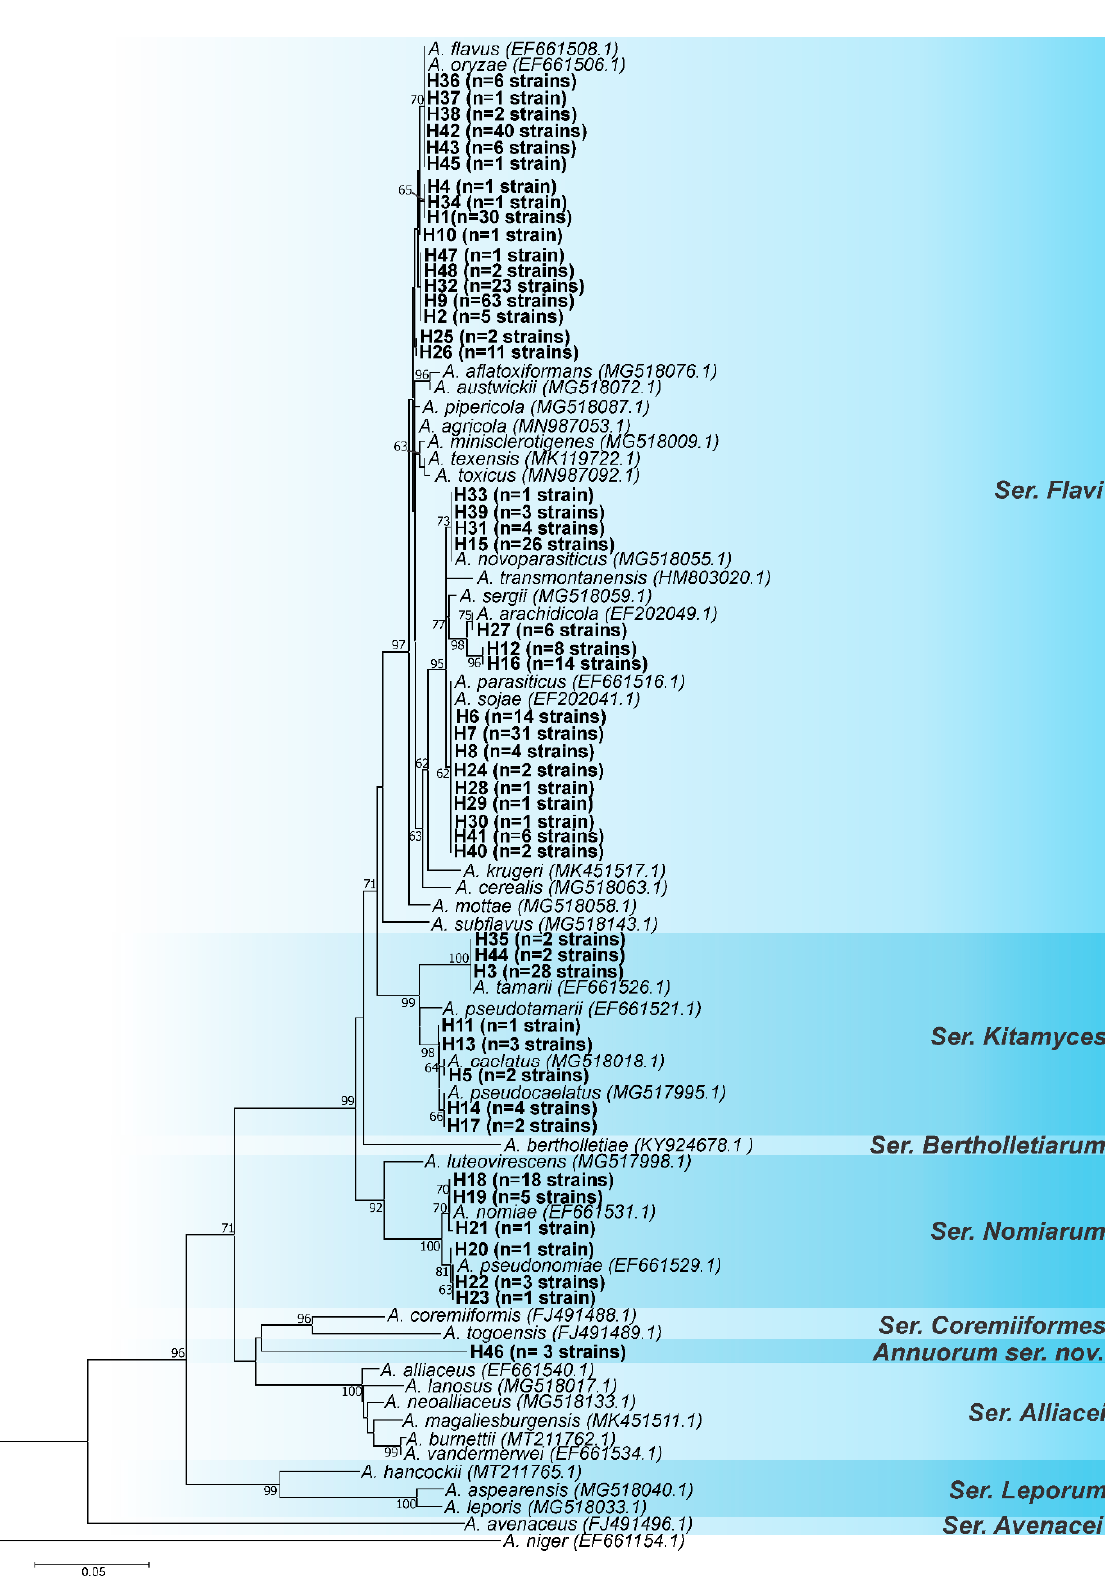
Figure 1. Maximum-likelihood tree of Aspergillus section Flavi based on CaM sequences. Haplotypes obtained in this study are indicated by the letter H in bold. Only bootstraps ≥ 60% are shown. Aspergillus niger is the outgroup.